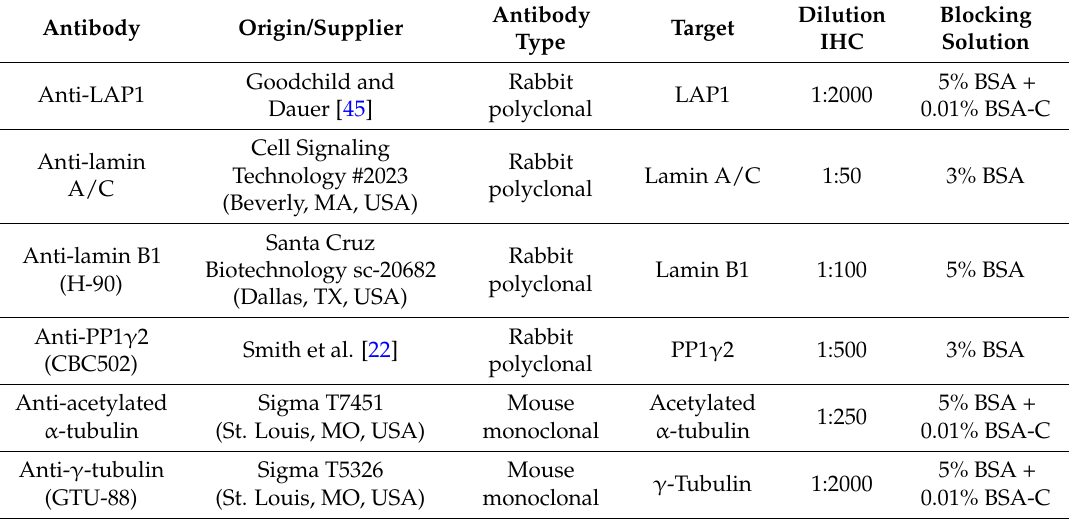
Table 3. Primary antibodies used to detect LAP1 and its interactors by immunohistochemical analysis, immunofluorescent colocalization assays and immunoblotting. Antibody